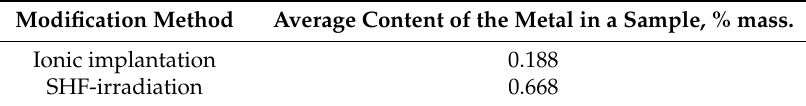
Table 2. Average content of nanoparticles Fe 0 in samples of composites.